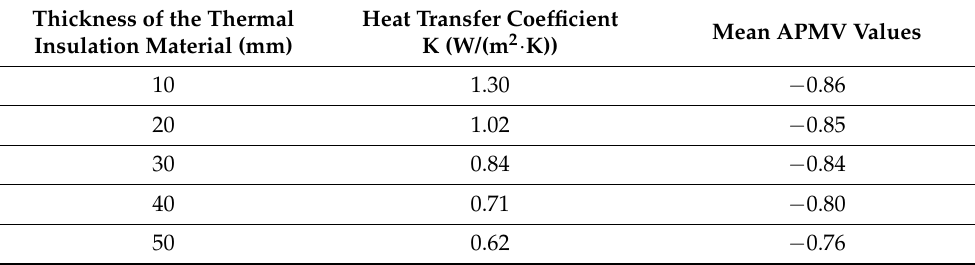
Table 2. The heat transfer coefficient of the envelope and the mean APMV values at different insulation